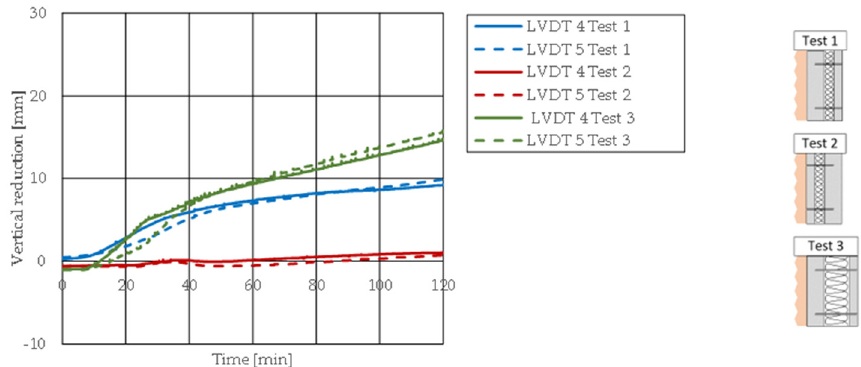
Figure 6. Deformation recordings in the vertical direction measured at the wall’s head.